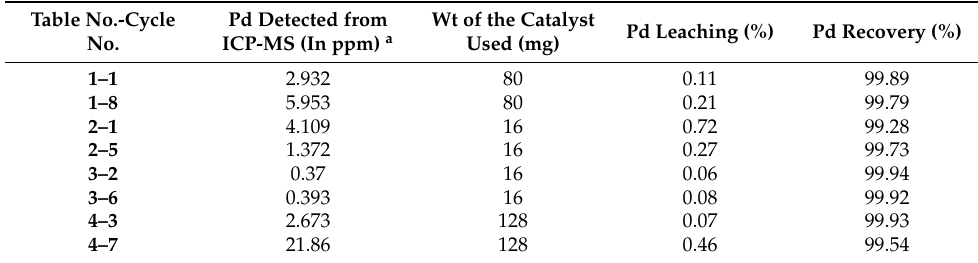
Table 12. Pd leaching (%) after 2a -catalyzed Stille coupling of aryl iodides from inductively coupled plasma mass spectrometry (ICP-MS). Table No.-Cycle No.